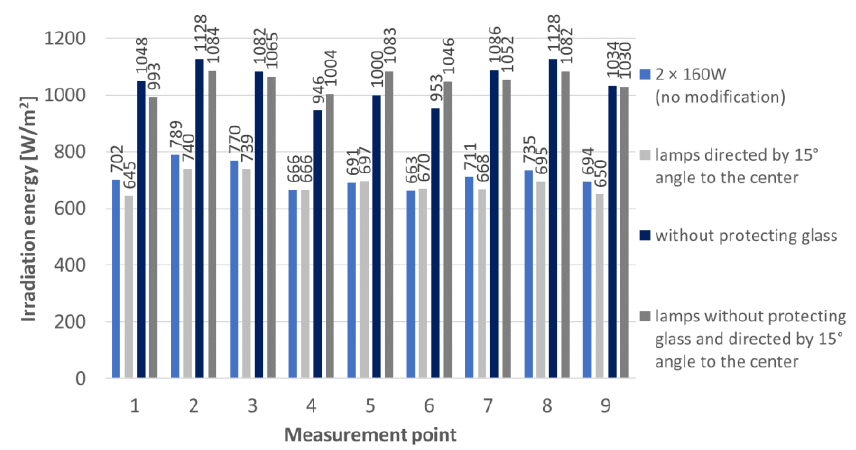
Figure 6. Irradiation intensity measured at the surface of the plate for the combination of two halogen lamps, each of 160 W power, both without and with the implemented modifications.